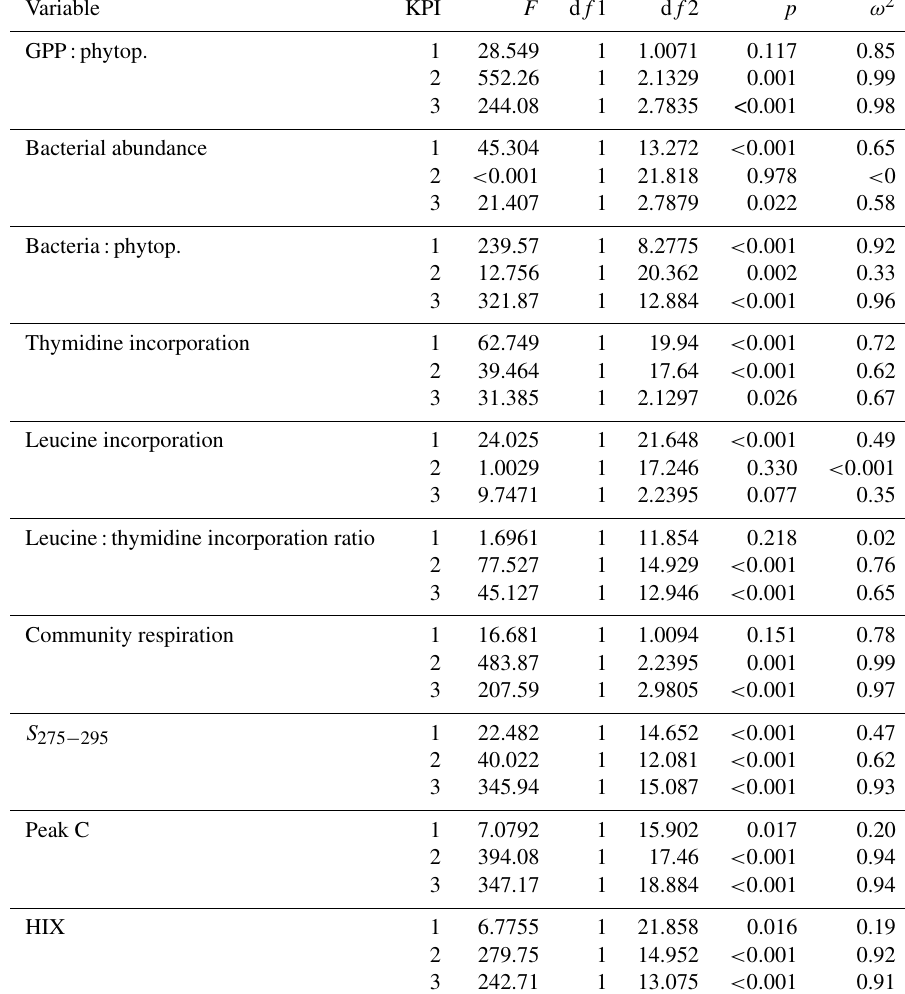
Table B1. Welch ANOVA results of the DOM release experiment. Each line presents the test of difference between the phytoplankton species for the given variable at the given